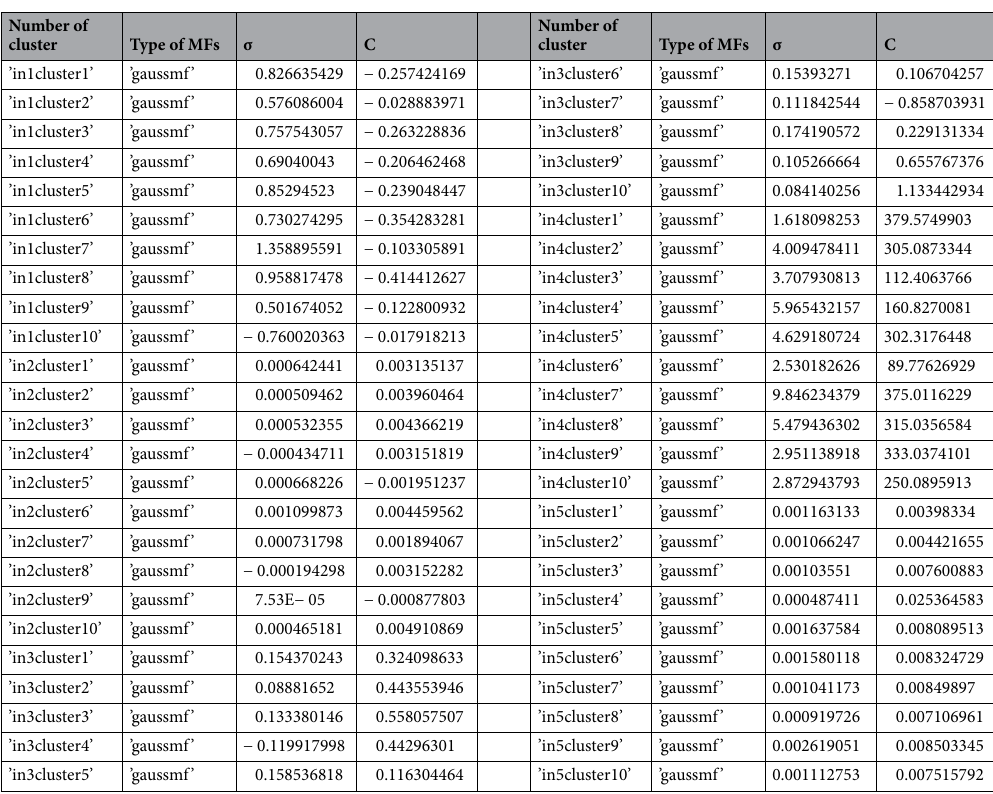
Table 3. Inputs membership functions parameters in GAFIS intelligence learning